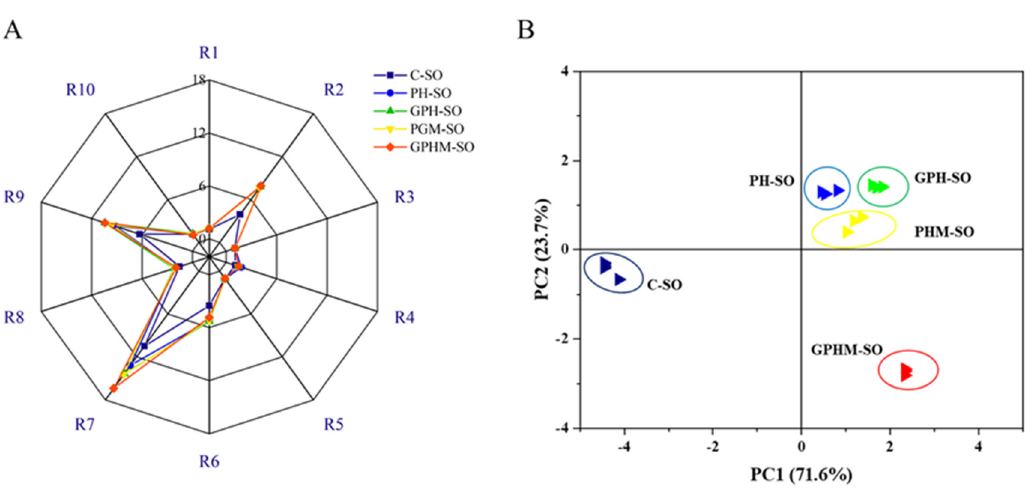
Figure 2. Electronic nose analysis of sesame oil with different treatments: ( A ) aromatic species analysis, ( B ) principal component analysis. Note: Sensors (R1, R2, R3, R4, R5, R6, R7, R8, R9, and R10) represented sensitivity for aromatic, nitrogen oxide, ammonia–aromatic, hydrogen, alkane–aromatic, broad-methane, sulfide, broad-alcohol, organic sulfur–aromatic, and broad-alkane com- pounds, respectively.